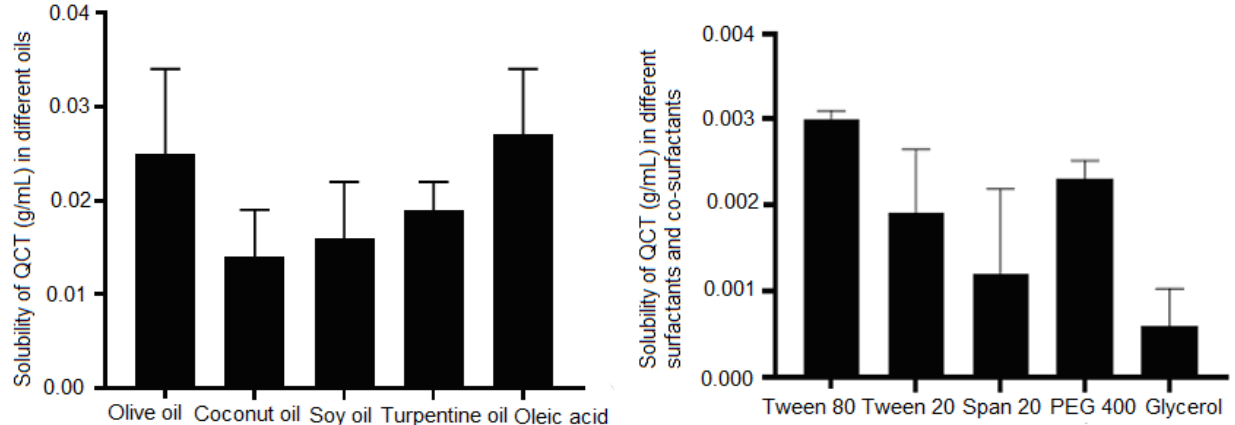
Figure 1. The solubility profile of QCT in different oils, surfactants and co-surfactants.